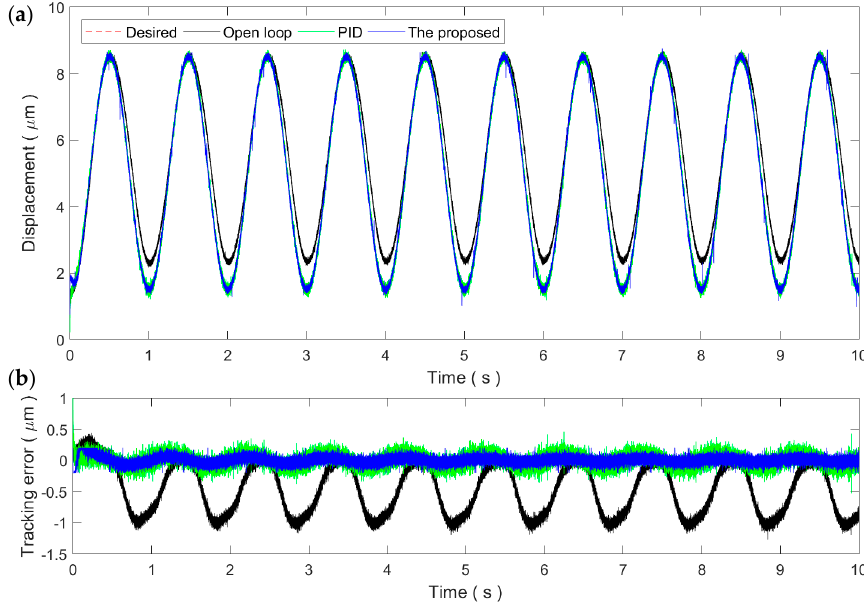
Figure 5. Tracking of the 1 Hz sinusoidal trajectory: ( a ) Time plot and ( b ) tracking error.